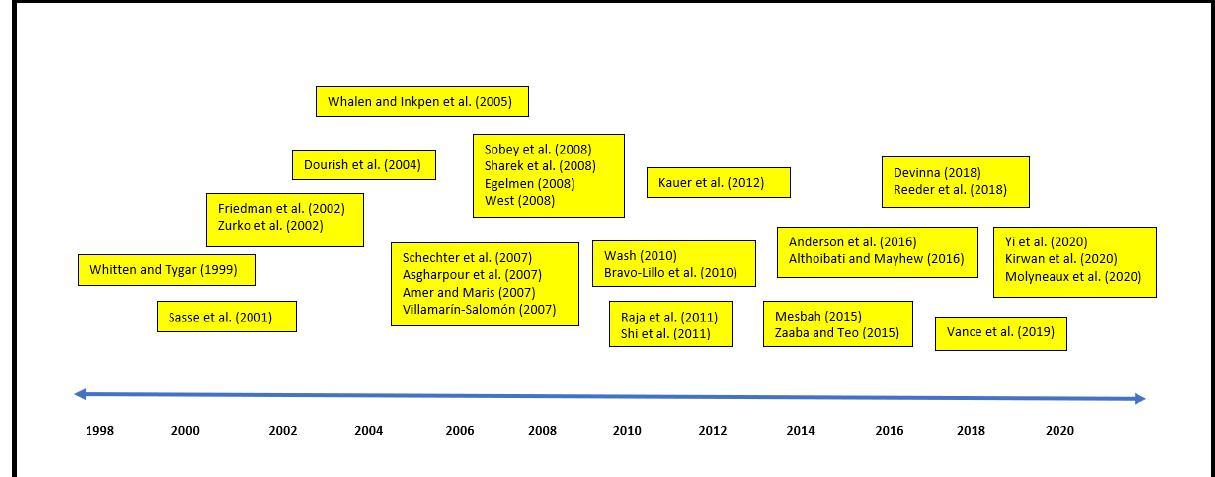
Figure A1. Timeline of problems and challenges in security warnings.